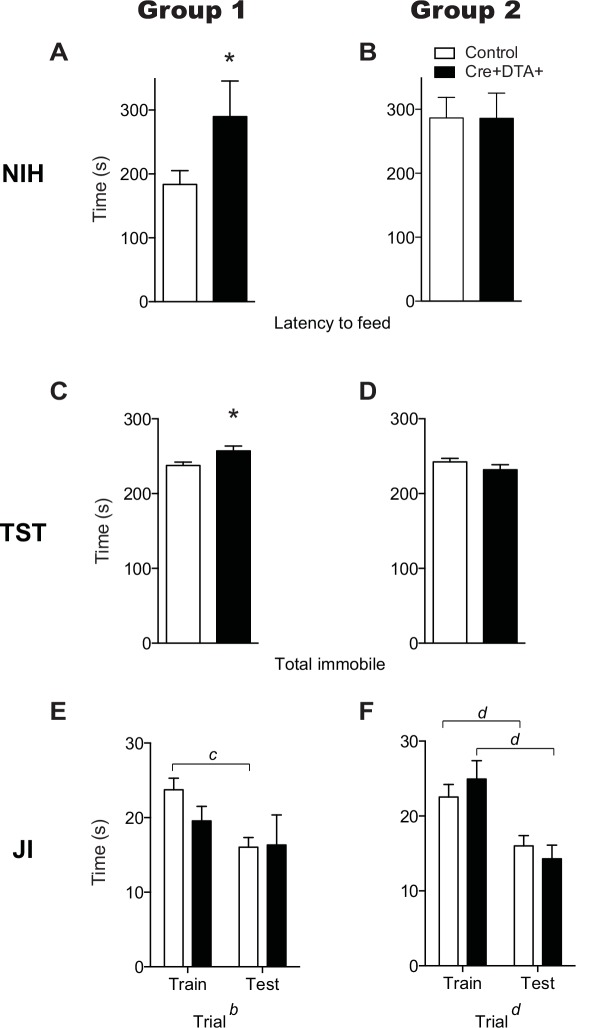
Relative to control mice, stress induced anxiety-like and depressive-like behavior are evident in Cre+DTA+ mice tested less than–but not more than– 4 weeks post-TAM.(A, B) Latency to feed in the novelty induced hypophagia test (NIH) in control vs. Cre+DTA+ mice at short (A, Group 1, control N = 31, Cre+DTA+ N = 10) and long (B, Group 2, control N = 39, Cre+DTA+ N = 16) TAM-behavior intervals. (C, D) Total immobility time in the tail suspension test (TST) in control vs. Cre+DTA+ mice at short (C, Group 1, control N = 27, Cre+DTA+ N = 9) and long (D, Group 2, control N = 38, Cre+DTA+ N = 15) TAM-behavior intervals. (E, F) Interaction time during juvenile interaction training and test sessions in control vs. Cre+DTA+ mice at short (E, Group 1, control N = 30, Cre+DTA+ N = 9) and long (F, Group 2, control N = 40, Cre+DTA+ N = 17) TAM-beh intervals. Data = mean±SEM. *p<0.05, unpaired two-tailed Student’s t-test (A-D). bp<0.01,cp<0.005, dp<0.0001, two-way ANOVA with repeated measures and Bonferroni posthoc.